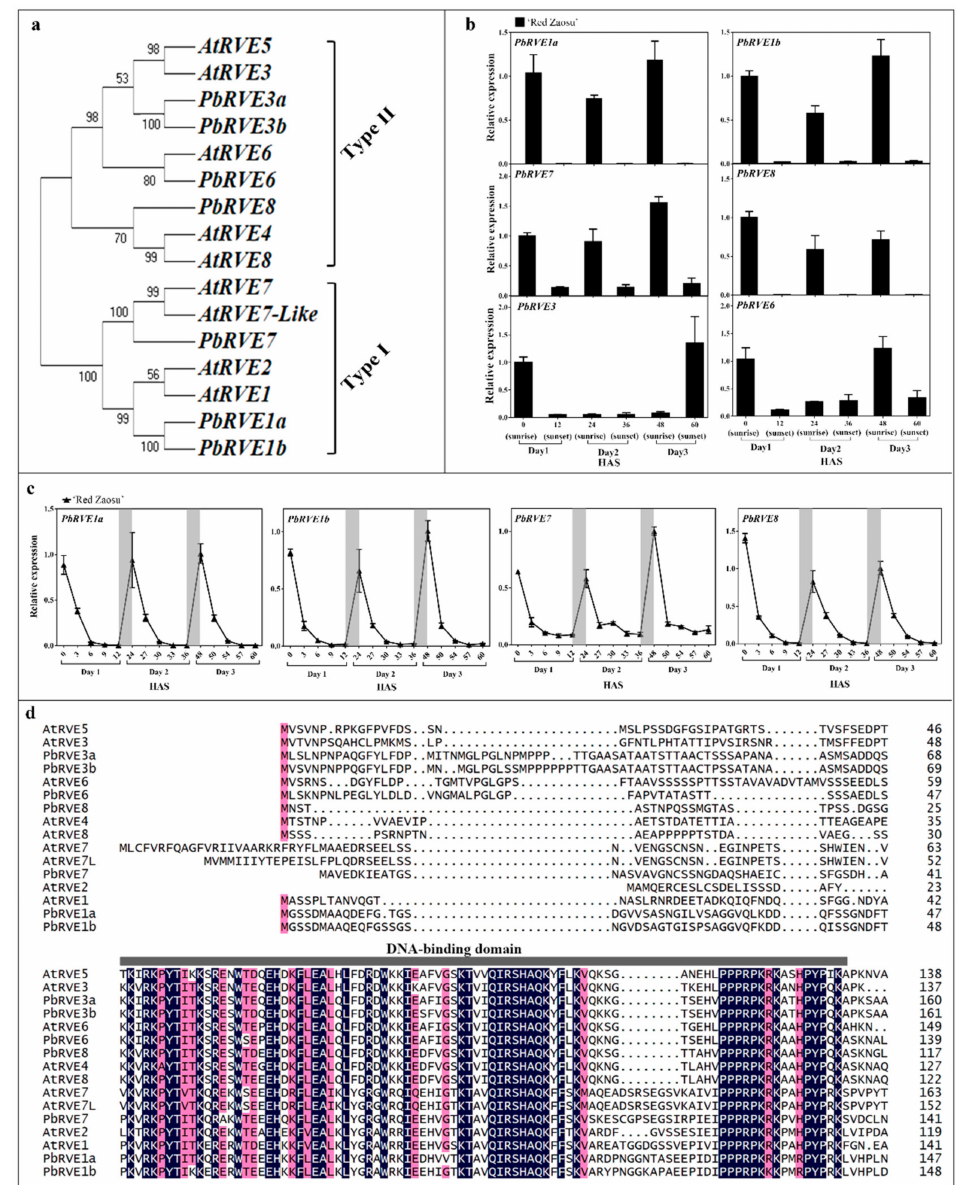
Figure 3. Phylogenetic analysis of REVEILLEs ( RVE s) and the expression patterns of PbRVE s in ‘Red Zaosu’ pear fruit skin. ( a ) Phylogenetic analysis of RVE proteins from pear and A. thaliana . The type I proteins are AtRVE7, AtRVE7-Like, PbRVE7, AtRVE1, AtRVE2, PbRVE1a and PbRVE1b; the type II proteins are AtRVE3, AtRVE5, PbRVE3a, PbRVE3b, AtRVE6, PbRVE6, PbRVE8, AtRVE4 and AtRVE8. ( b ) The expression patterns of PbRVE s in ‘Red Zaosu’ fruit skin at sunrise and sunset over three continuous days. HAS: hours after sunrise of day 1. The actual transcript abundance data of PbRVEs are listed in Supplementary Table S3. ( c ) The expression patterns of PbRVE1a , 1b , 7 and 8 in ‘Red Zaosu’ fruit skin over three continuous days. The gray boxes indicate nighttime. ( d ) Multiple sequence alignment of RVE proteins. RVE proteins were aligned using ClustalW. The DNA-binding domain is indicated by a horizontal gray bar. The phylogenetic analysis was constructed with the Neighbor-joining method (1000 replications bootstrap test and JTT model distribution) using MEGA 7.0. The protein sequences of the RVEs were obtained from the pear genome. The gene accession numbers are listed in Supplementary Table S1. Error bars represent SEs of the means ( n =